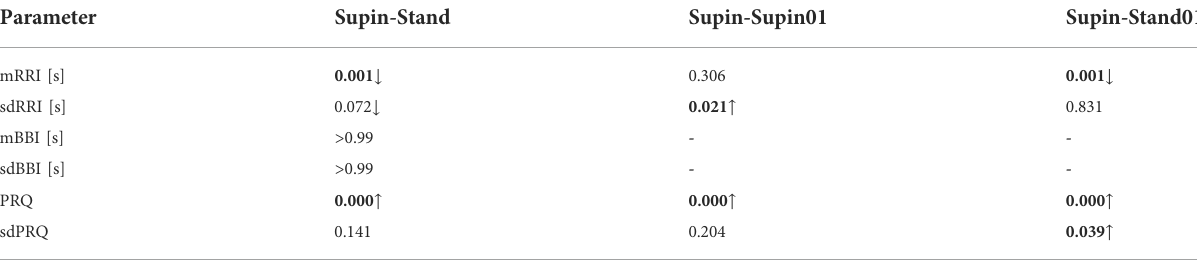
TABLE 2 Change of RRI, BBI andPRQ under different conditions (Post hoc Mann-Whitney test for independentsampleswith Bonferroni corrected p - value ( p -value · m < 0.5, for m = 3, where m is the number of comparisons) after Kruskal – Wallis test for multiple comparisons for 20 healthy subjects;directionofchange: ↓ -decrease; ↑ -increase);Boldfontindicatesstatisticallysigni fi cantchanges(pvaluelessthan0.05);graycoloroffont indicateavaluecloseto0.5whichcouldberegardedasastatisticallysigni fi cantchange.(AdoptedfromMati ć etal.,2020andcompletedbyPRQdata for comprehensive analysis).